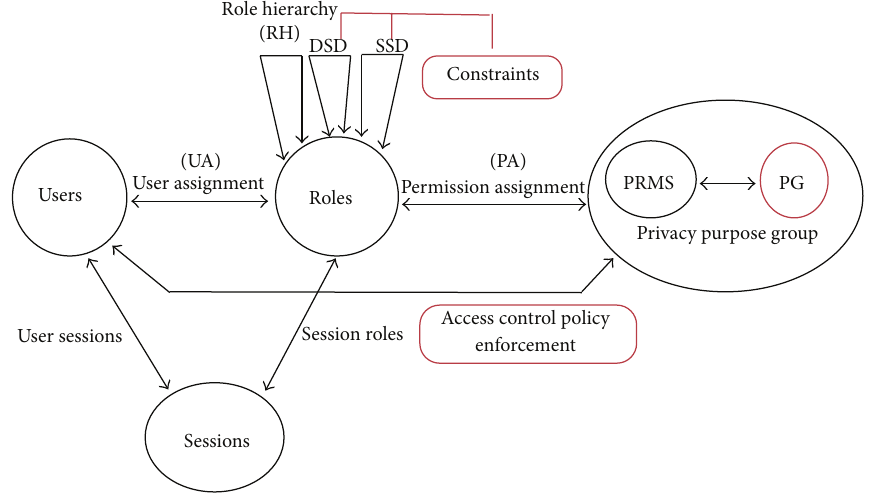
Figure 6: Extended RBAC security model.